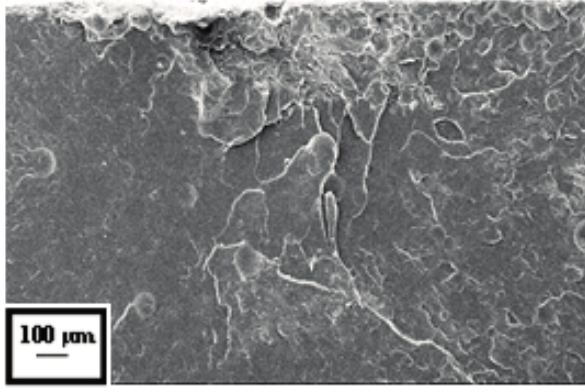
Figure 3. SEM micrograph of mirror zone in PMMA.